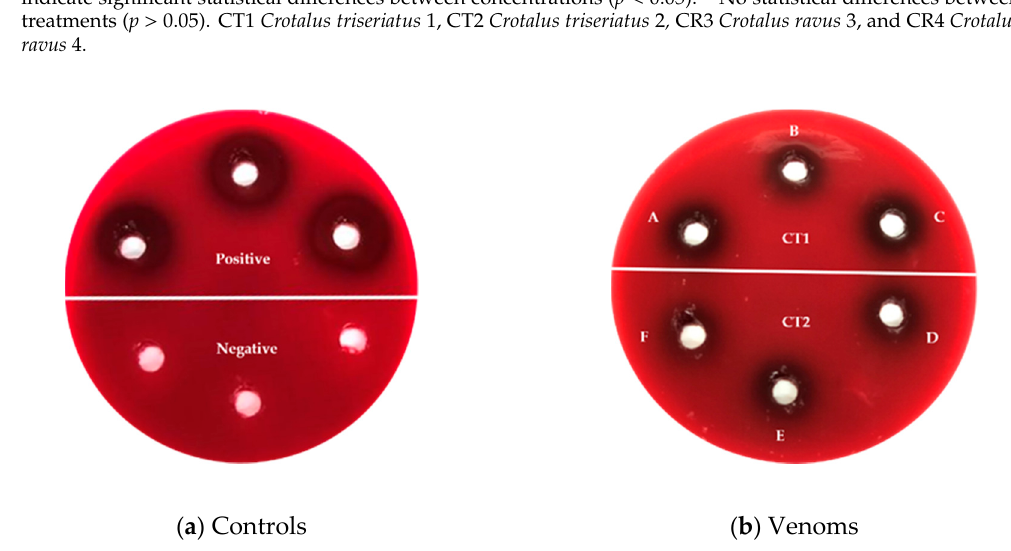
Figure 3. Indirect hemolytic activity of the rattlesnake’s venoms: ( a ) hemolytic activity of controls, positive Tween 80, negative nutritive broth; ( b ) hemolytic activity of venoms A , B , C 100 µg/mL of CT1; D , E , F 100 µg/mL of CT2.